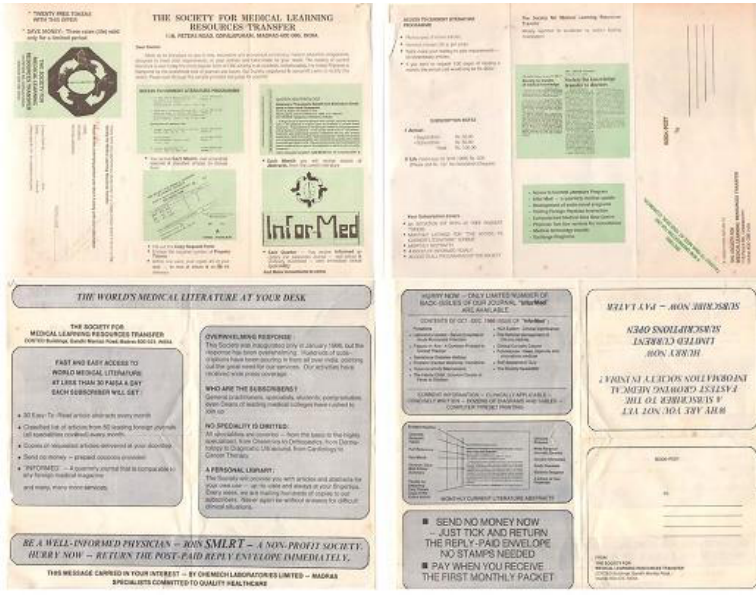
Figure 1 Pamphlet explaining services offered by